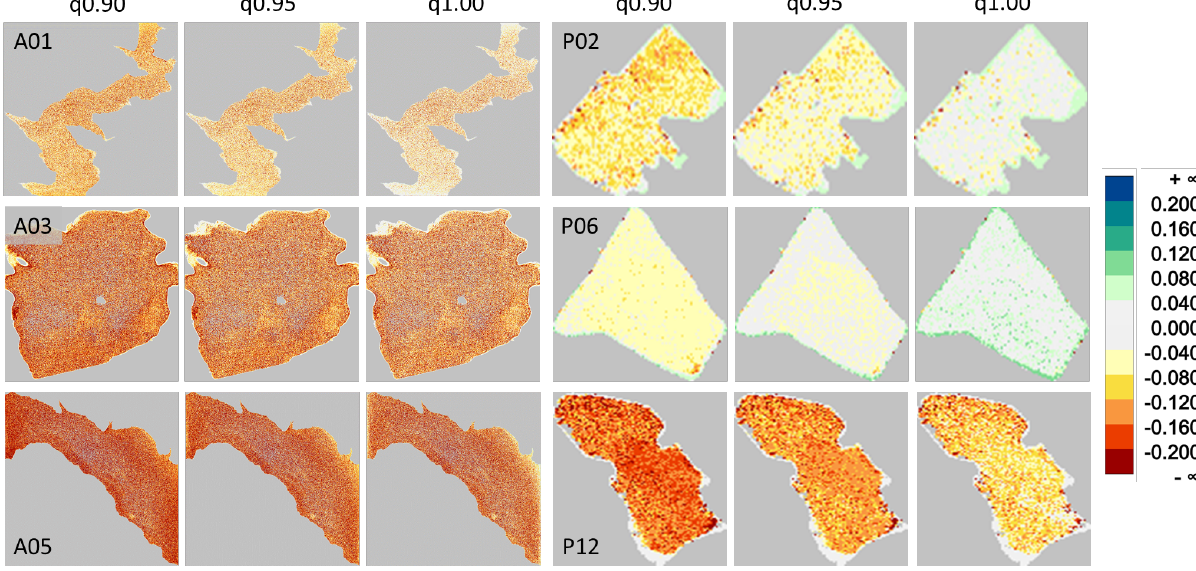
Figure 6. Deviations between reference water level and 2m digital water surface model grids calculated for selected Single Photon and Multi-Photon LiDAR water bodies and different water level height